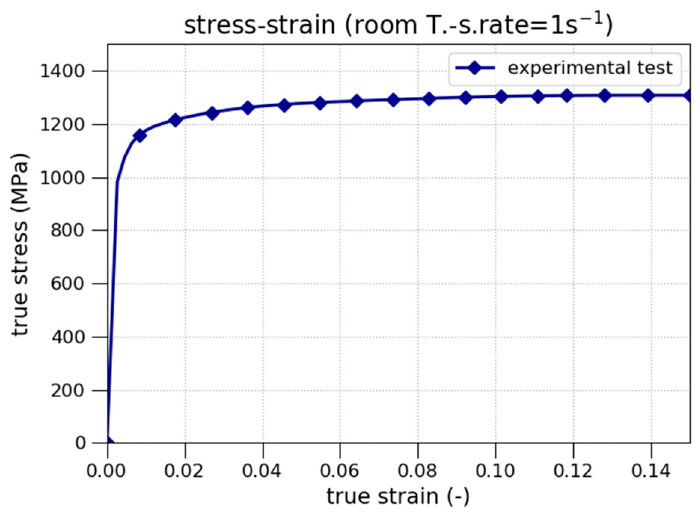
Figure 2. True stress–strain curves at room temperature and the reference strain rate.